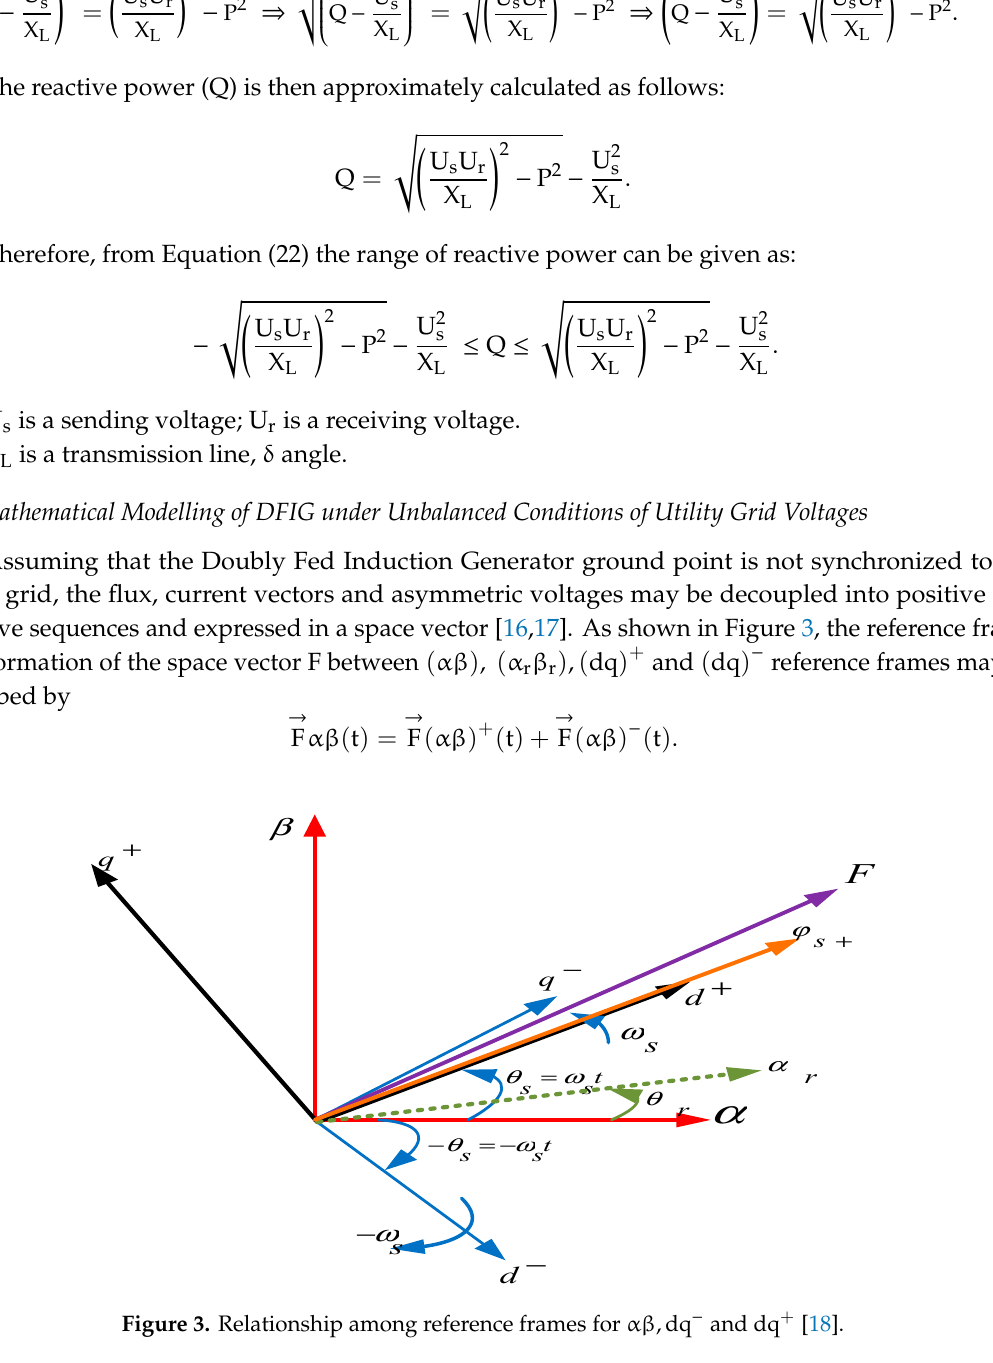
Figure 3. Relationship among reference frames for αβ, dq (cid:2879) and dq (cid:2878) [18].